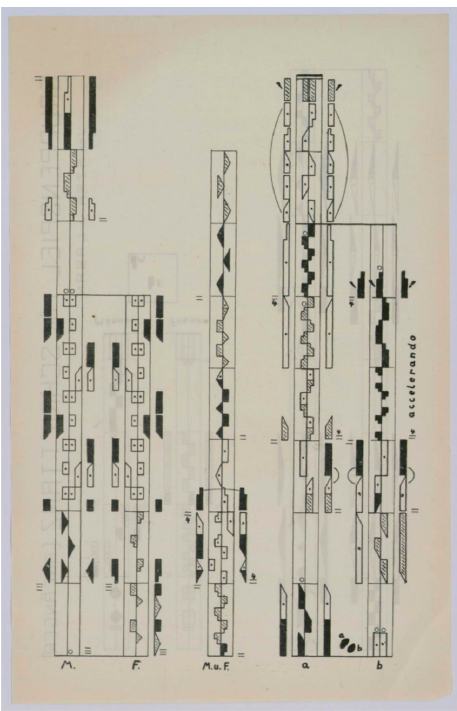
Figure 11. Azra von Laban, Gruppenspiel für Schrifttanz, notated 1930–1931. Médiathèque du Centre national de la danse. Fonds Albrecht Knust. Donation by Roderyk Lange, used by permission.